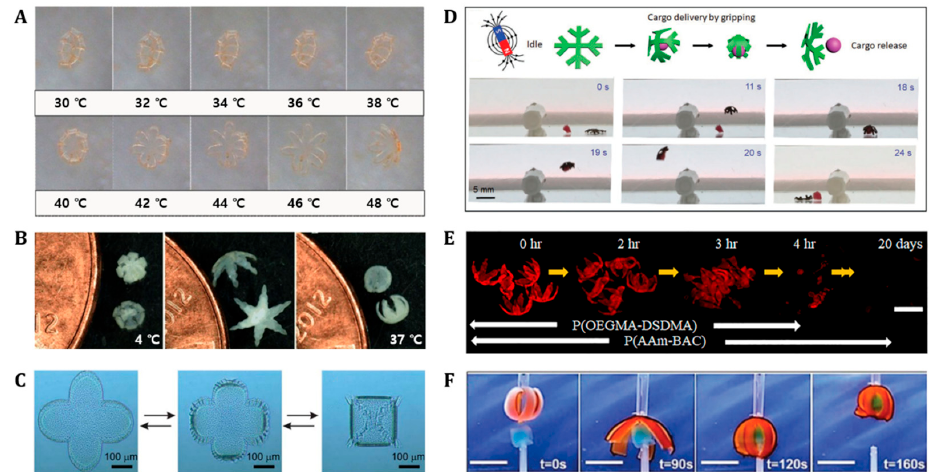
Figure 5. Biodegradable grippers as actuators . ( A ) Temperature-dependent unfolding of long Venus flytrap-like hydrogel grippers. Reproduced with permission [98]. Copyright 2014, Wiley-VCH. ( B ) Theragrippers originally closed at 4 °C, open as the temperature increased and finally closed again in the opposite direction at 37 °C. Reproduced with permission [88]. Copyright 2013, The American Chemical Society. ( C ) Self-folding of the thermoresponsive star-shaped bilayer gripper. Reproduced with permission [149]. Copyright 2013, The Royal Society of Chemistry. ( D )